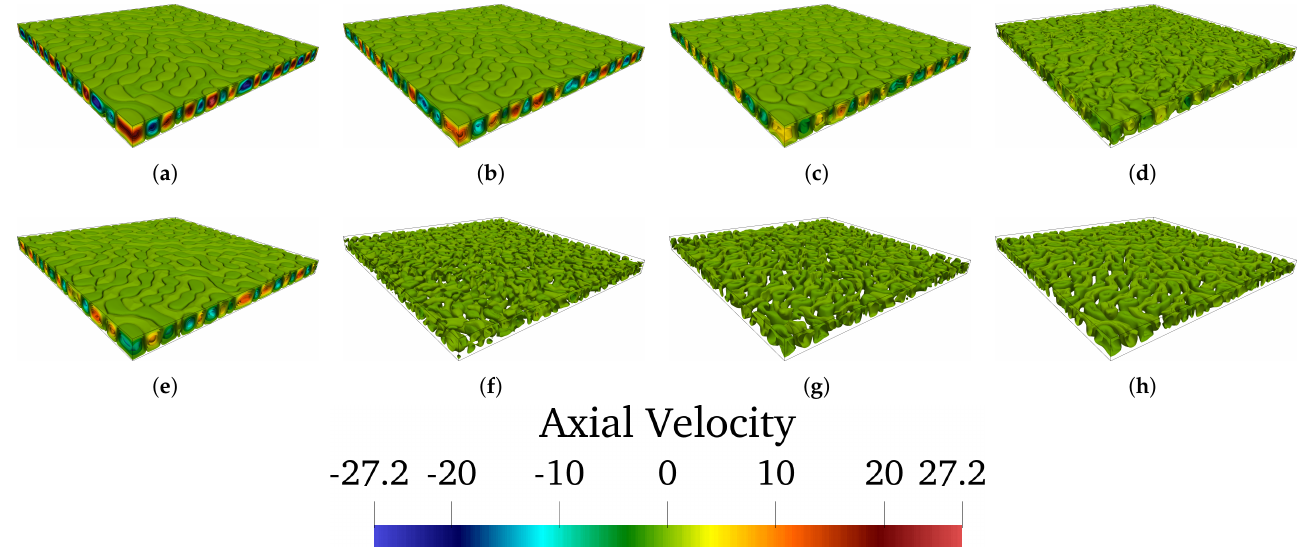
Figure 6. Thermovibrational convection in a layer of FENE-CR fluid delimited by differentially heated solid walls (snapshots of the isosurfaces of the vertical component of velocity evenly distributed over the interval I 1 ). Pr g = 8, Ω = 25, Ra ω = 4000, ξ = 0.5, ϑ = 0.1, pulse wave